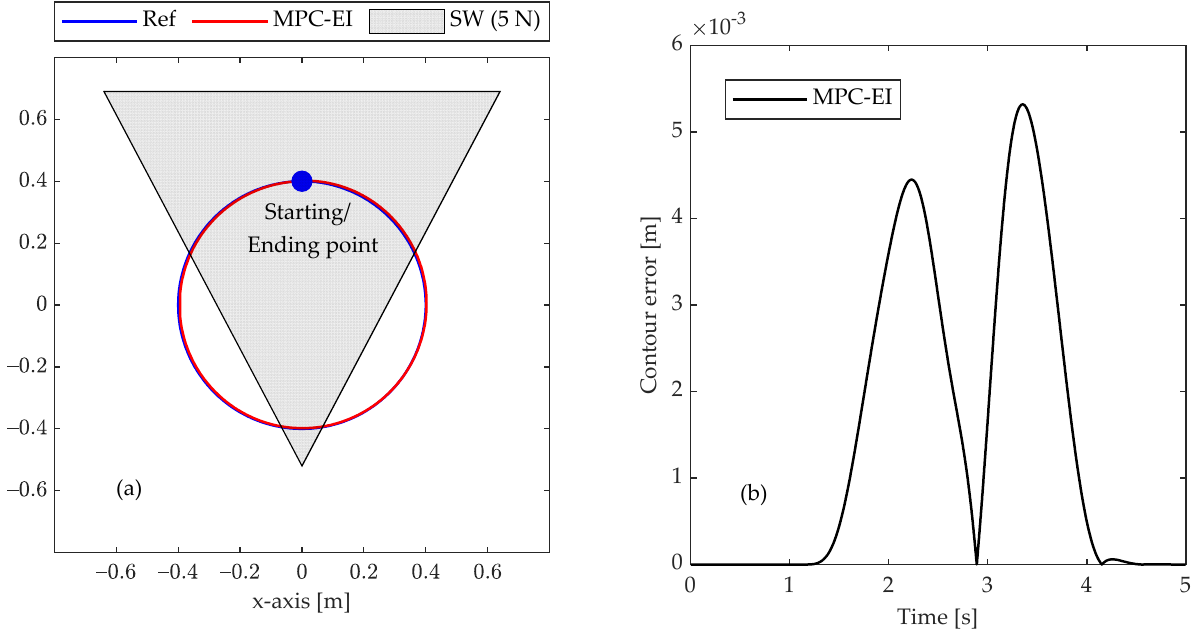
Figure 6. Path tracking response of the circular path: spatial representation ( a ) and its contour error ( b ).